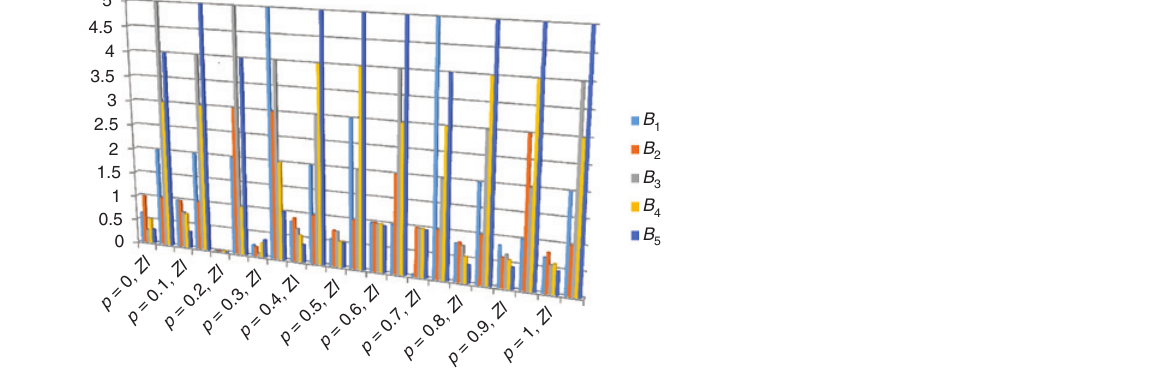
Figure 6: The Variation Analysis of Collective Index Values for the Candidates using each Identification Coefficient